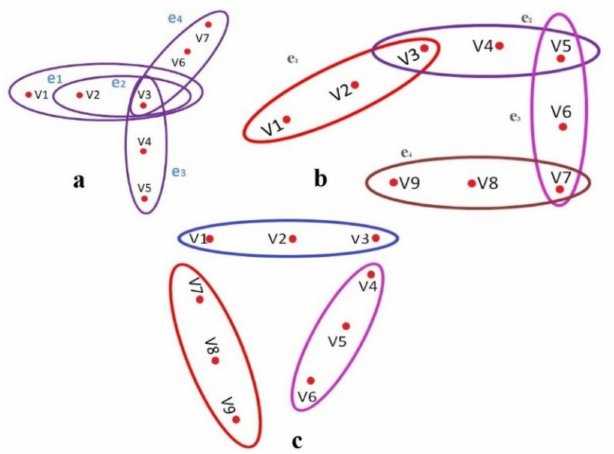
Figure 6. Hypergraph representation of data: ( a ) intersecting hyper-edges with common intersection (Exploits Helly property), ( b ) pairwise intersecting hyper-edges without common intersection (Lack of Helly property) and ( c ) isolated